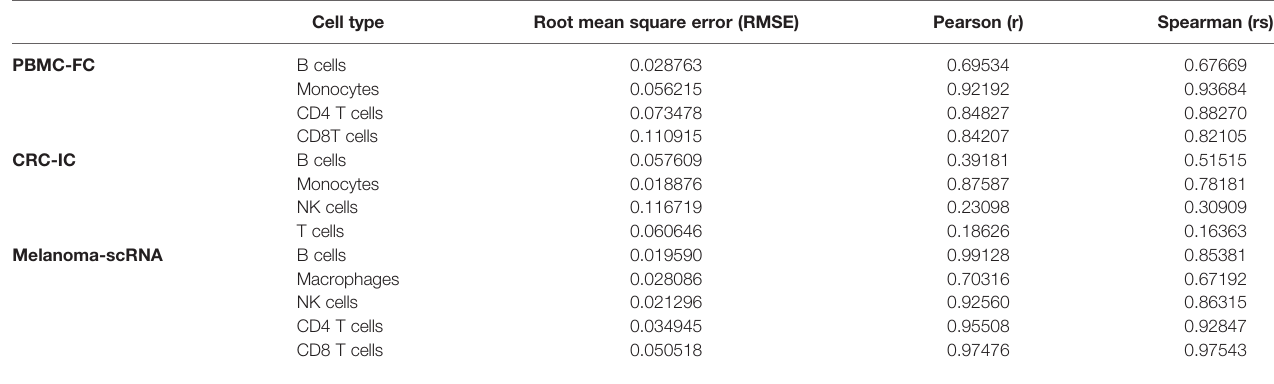
TABLE 2 | Immune cell error table of three data sets.